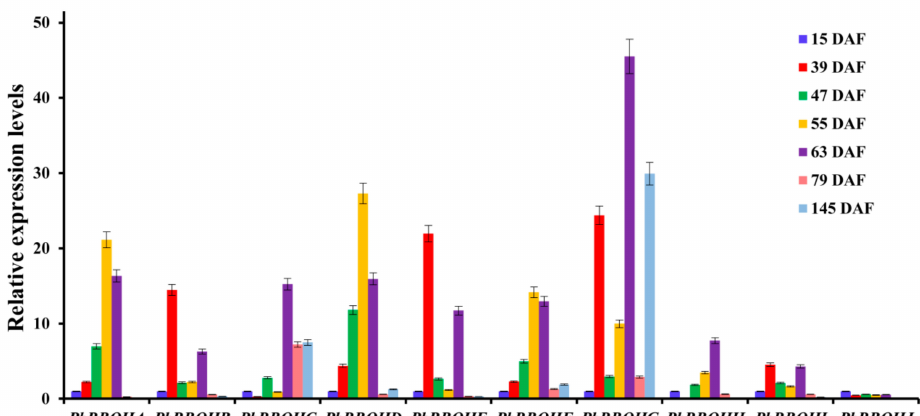
Figure 9. Expression profiles of pear RBOH s across di ff erent developmental stages. The expression level of 10 PbRBOH s in pear fruits at eight developmental stages (15 DAF, 39 DAF, 47 DAF, 63 DAF, 79 DAF, and 145 DAF). The relative expression level was calculated by setting the expression value of PbRBOH s in fruit (15 DAF) of pear at 1.